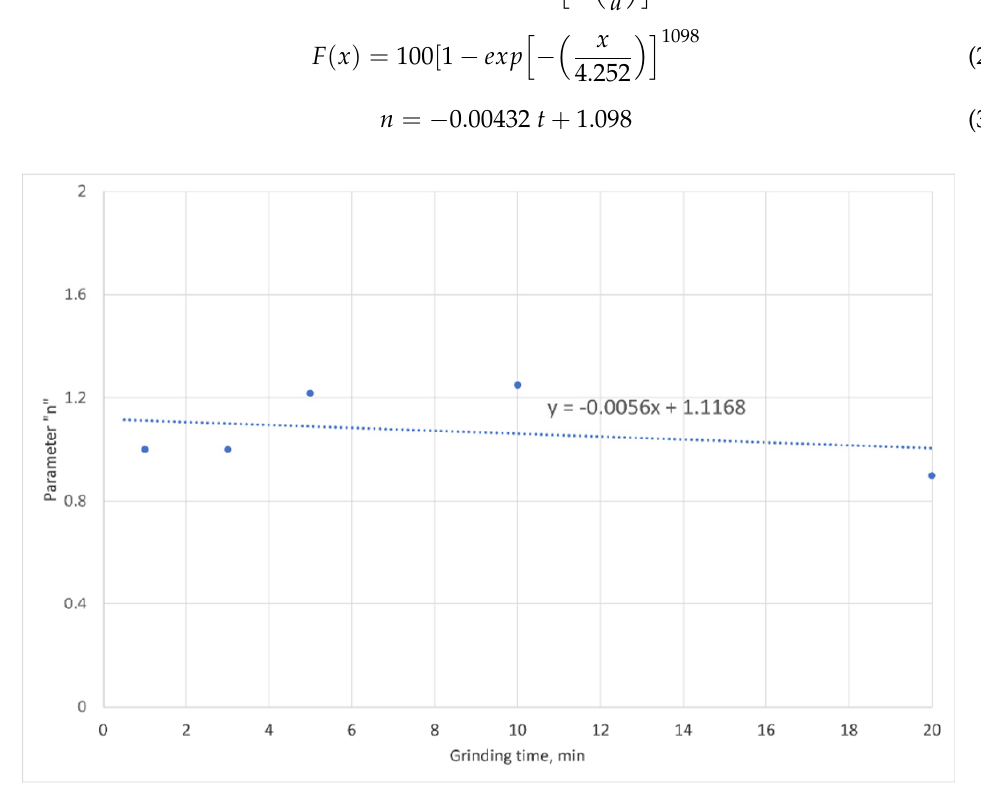
Figure 1. The values of exponent “ n ” depending on the grinding